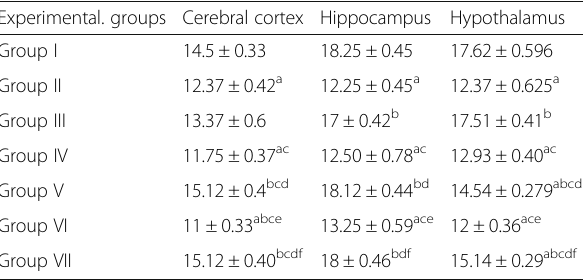
Table 7 The activities of acetylcholinesterase ( μ mol SH/g/min) in the cerebral cortex, hippocampus, and hypothalamus of male offspring in groups I to VII, 70 days postnatal. Data were presented as a mean of eight rats ±